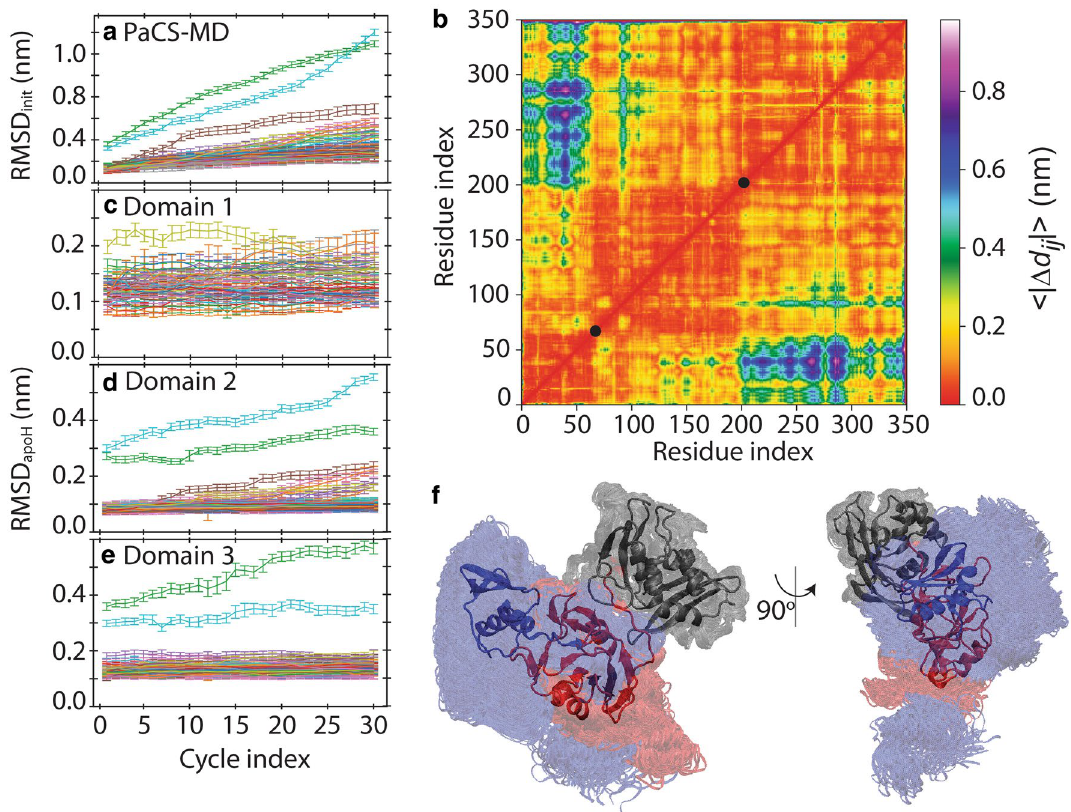
Figure 2. Conformational variation of the Nsp15 monomer. ( a ) Root-mean-square deviation (RMSD init) and its standard deviations (error bars). ( b ) Change in the inter C α distance between the initial and final snapshots (cid:31) (cid:31) of rmsdPaCS-MD averaged over trials, (cid:31) (cid:31) (cid:30) . The color of a point specified by the residue indices i and (cid:31) (cid:31) d ij (cid:31) (cid:31) j identifies the value of (cid:31) (cid:31) (cid:30) , as shown in the color bar on the right. The two filled black circles indicate (cid:31) (cid:31) d ij the borders of the three domains. ( c, d, e ) RMSD of each domain compared to that of the crystal structure (RMSD apoH ). ( f ) Visualization of the last frames at cycle 30 in all rmsdPaCS-MD trials after performing best- fitting of the backbone atoms of C-term domain. Each domain is specified by a distinct color, as in Fig.